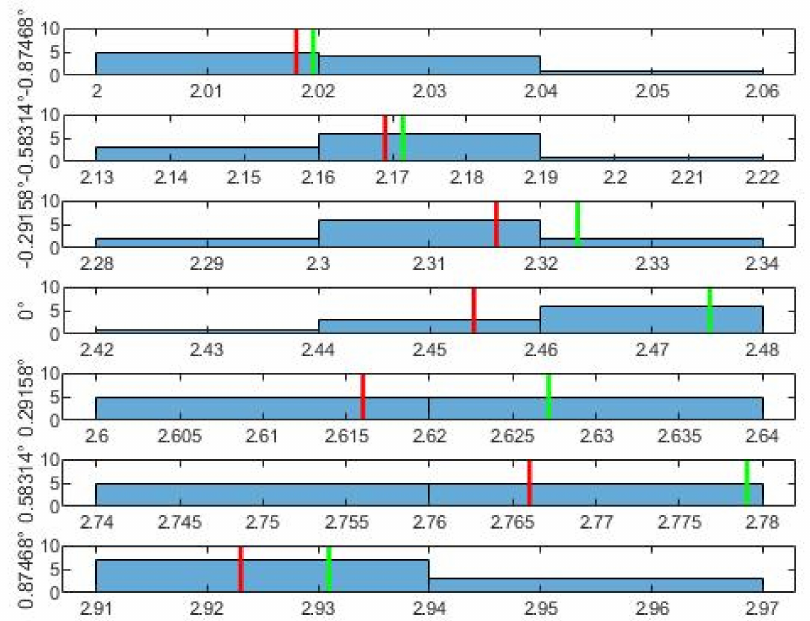
Figure 6. Histograms of the second 7 measurements. On the left there is the appropriate angle and multitude. The red line is the mean u ; the green line is the LSM value of u appropriate to angle.